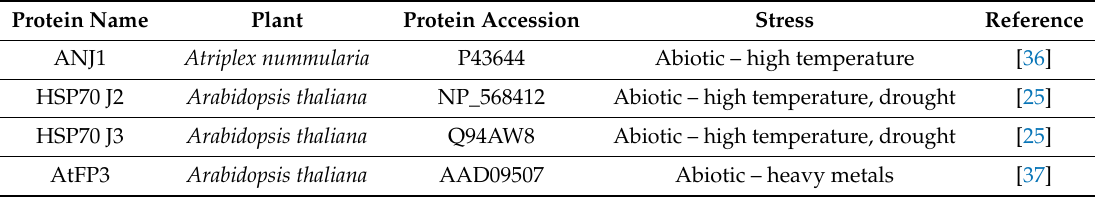
Table 1. Isoprenylated proteins involved in plant stress